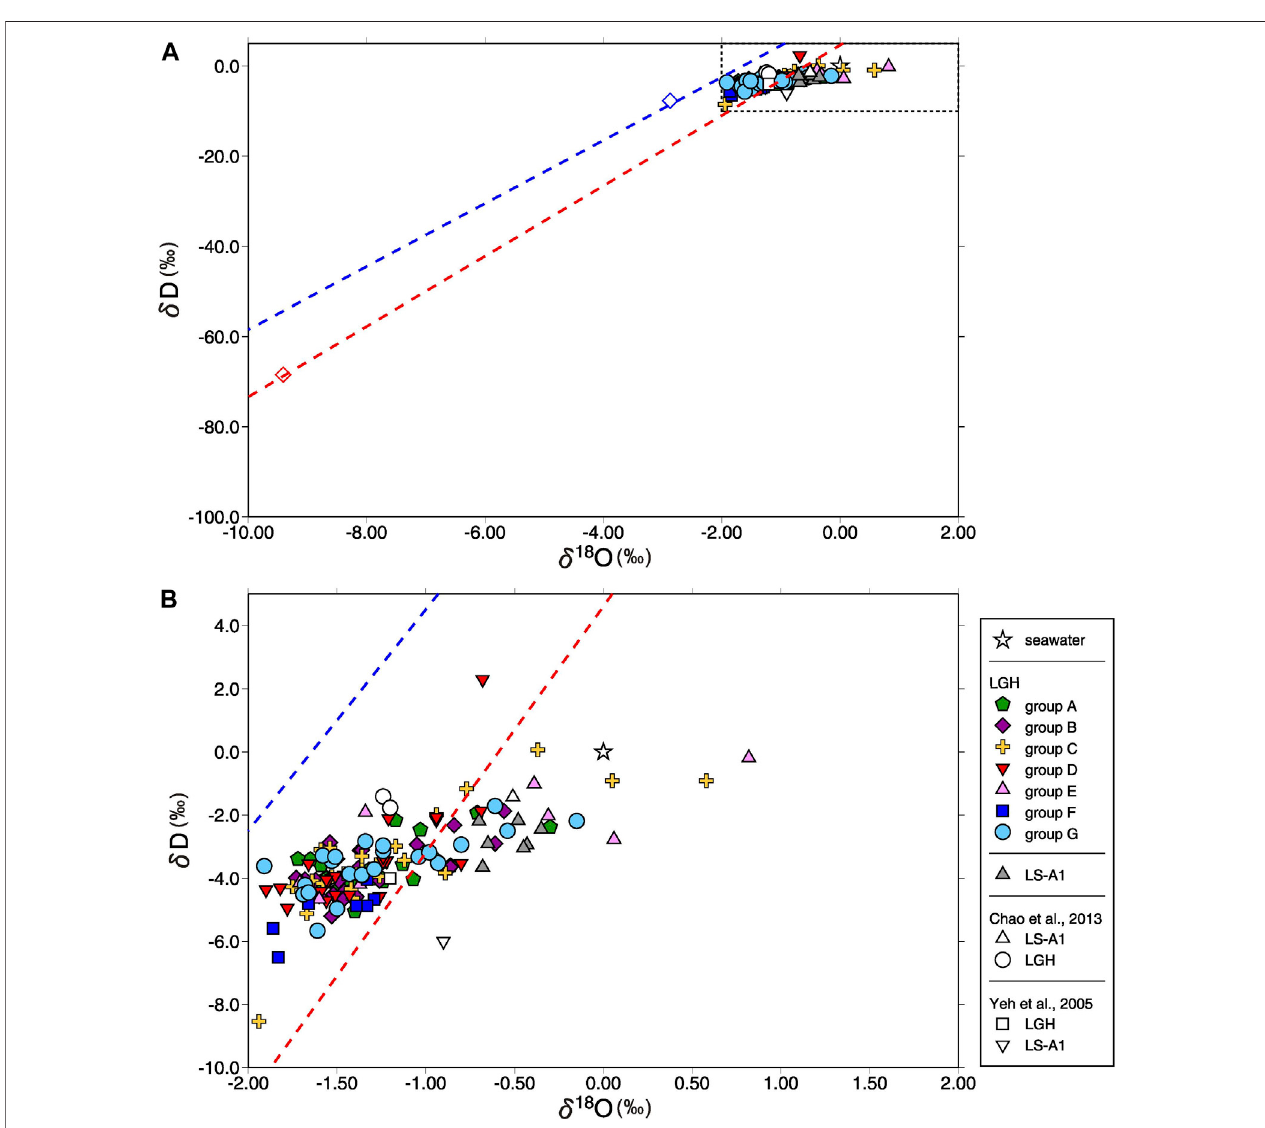
FIGURE6| Plotof δ Dvs. δ 18 Ofor (A) allmudvolcano fl uidsinthisstudy, (B) zoomoutofthedashedarea.Seawatercomposition,literatureresults(Yehetal.,2005; Chao et al., 2013), and local meteoric water line (Peng et al., 2010) are shown for reference. Blue dash line denotes local meteoric water line of the winter monsoon with the volume weightedaveragevalue (open blue diamond) and red dash linedenotes localmeteoricwater lineofthe summermonsoon with thevolumeweighted average value (open red diamond). The reproducibility is smaller than the symbol. The slope of increasing trend is approximately 2, possibly implying local evaporation line.